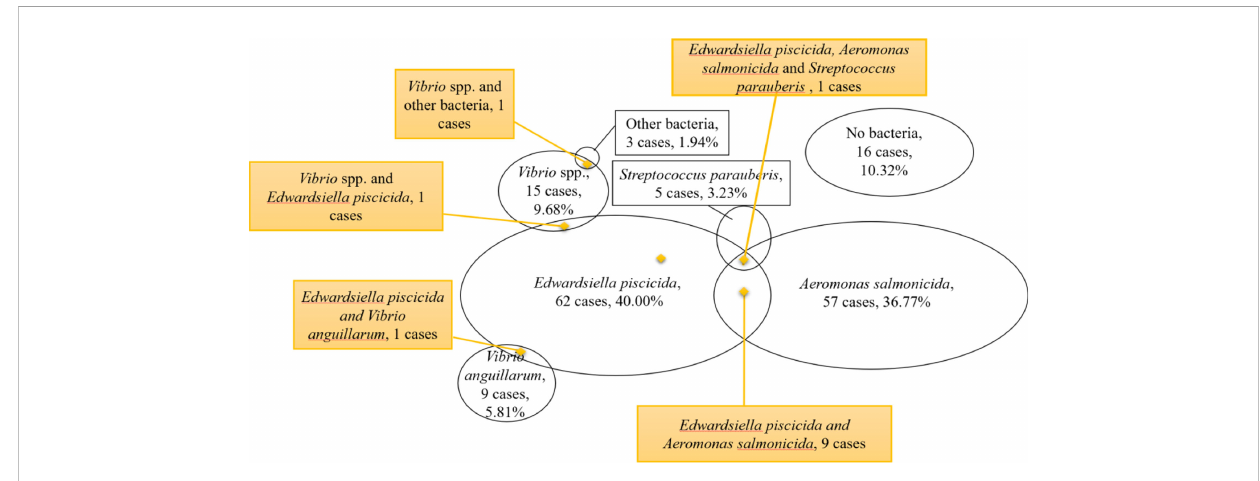
FIGURE 2 The percentage of pathogens isolated from turbot farm cases from 2016 to